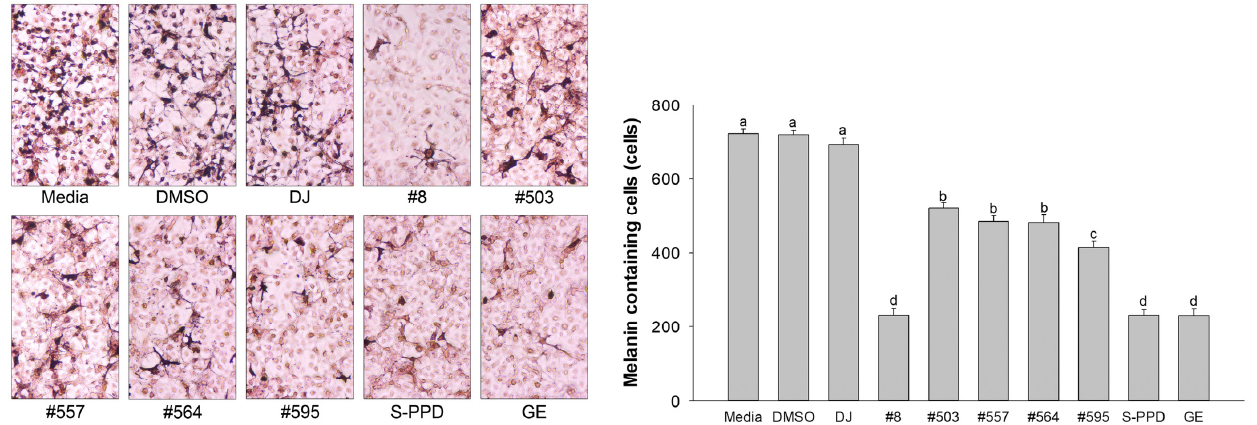
Figure 5. Effects of the PPD-enriched transgenic rice seed extracts on melanin-containing melan-a cells. Melanin-containing melan-a cells were counted by observing 1000 cells under a microscope. DJ, #8, #503, #557, #564, and #595 concentrations were 100 µg/mL. DMSO, S-PPD, and GE concentrations were 0.1%, 700 pg/mL, and 100 µg/mL, respectively. Data are shown as mean ± standard deviation ( n = 3). Lowercase letters indicate significant differences at p < 0.05 among the treatments.